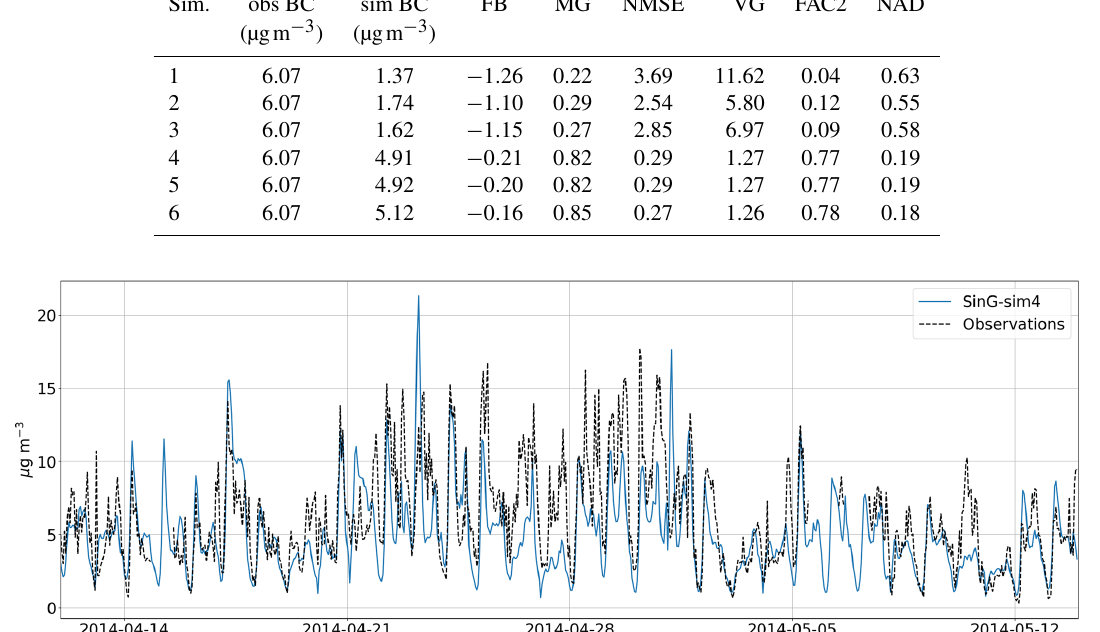
Table 2. Comparisons of BC measurements in Boulevard Alsace Lorraine: statistical indicators obtained for the different SinG simulations. The reader is referred to Appendix A for the definitions of the statistical parameters shown in the table. Sim.